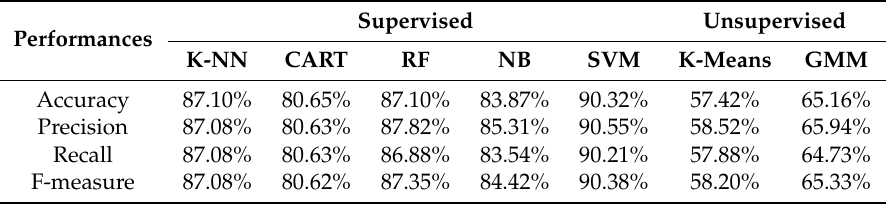
Table 14. Accuracy, Precision, Recall and F-measure for each classifier, obtained from the binary classification between PD and Healthy subjects.